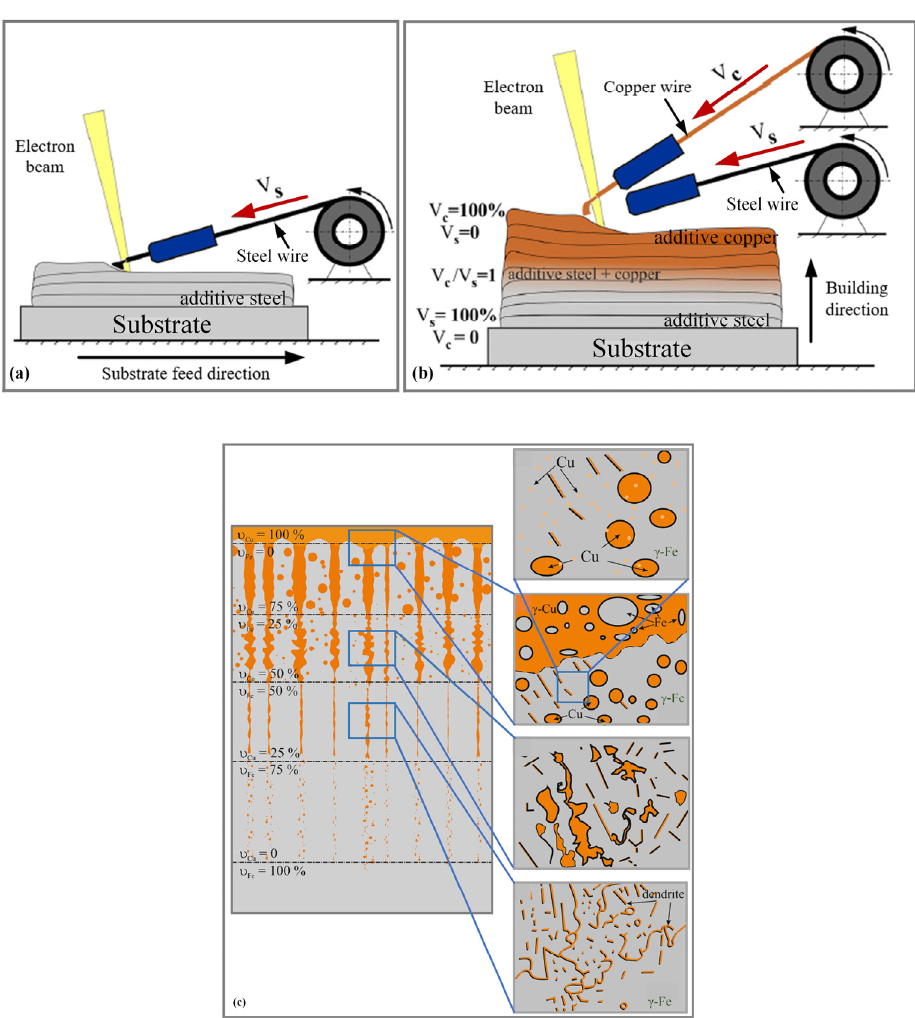
Figure 12. Schematic of the fabrication of FGMs by EBWAM: ( a ) SS wire deposition, ( b ) Copper wire deposition, ( c ) Microstructural scheme of the evolution of microstructure for the gradient zone [66].